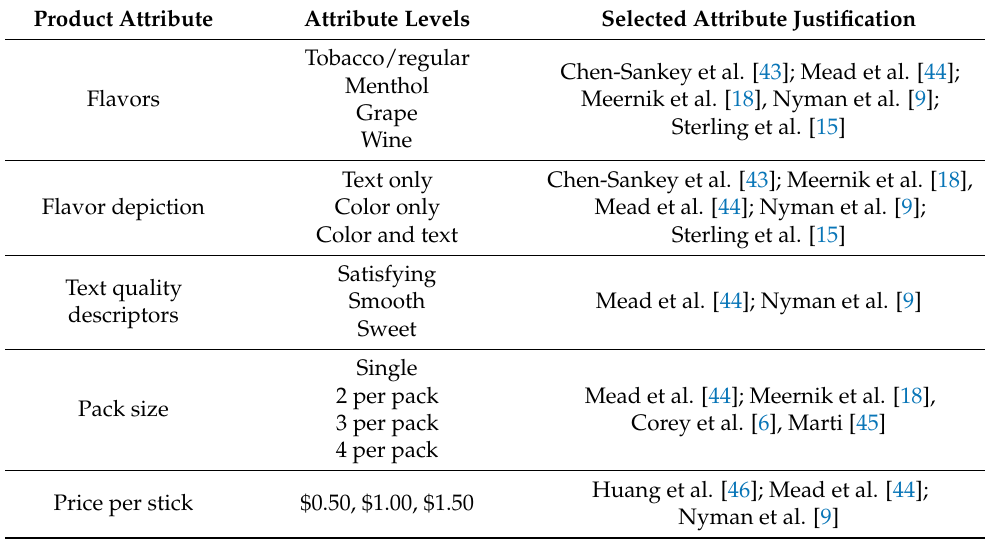
Table 1. Product attributes and